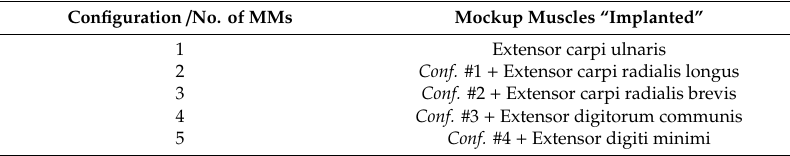
Figure 3. The experimental setup. ( a ) The acquisition unit (AU) samples the magnetic field produced by a single magnet (MM) mounted on a 3D positioning platform, across a ~85,000 mm 3 workspace. ( b ) The AU samples the field produced by five magnets anchored on the simulated muscles on the forearm mockup (Table 1). The computation unit (CU) is not shown. Table 1. Experimental conditions tested using the forearm mockup. Table 1. Experimental conditions tested using the forearm